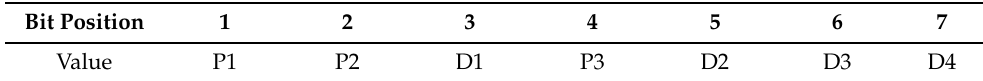
Table 2. Hamming(7,4) bit